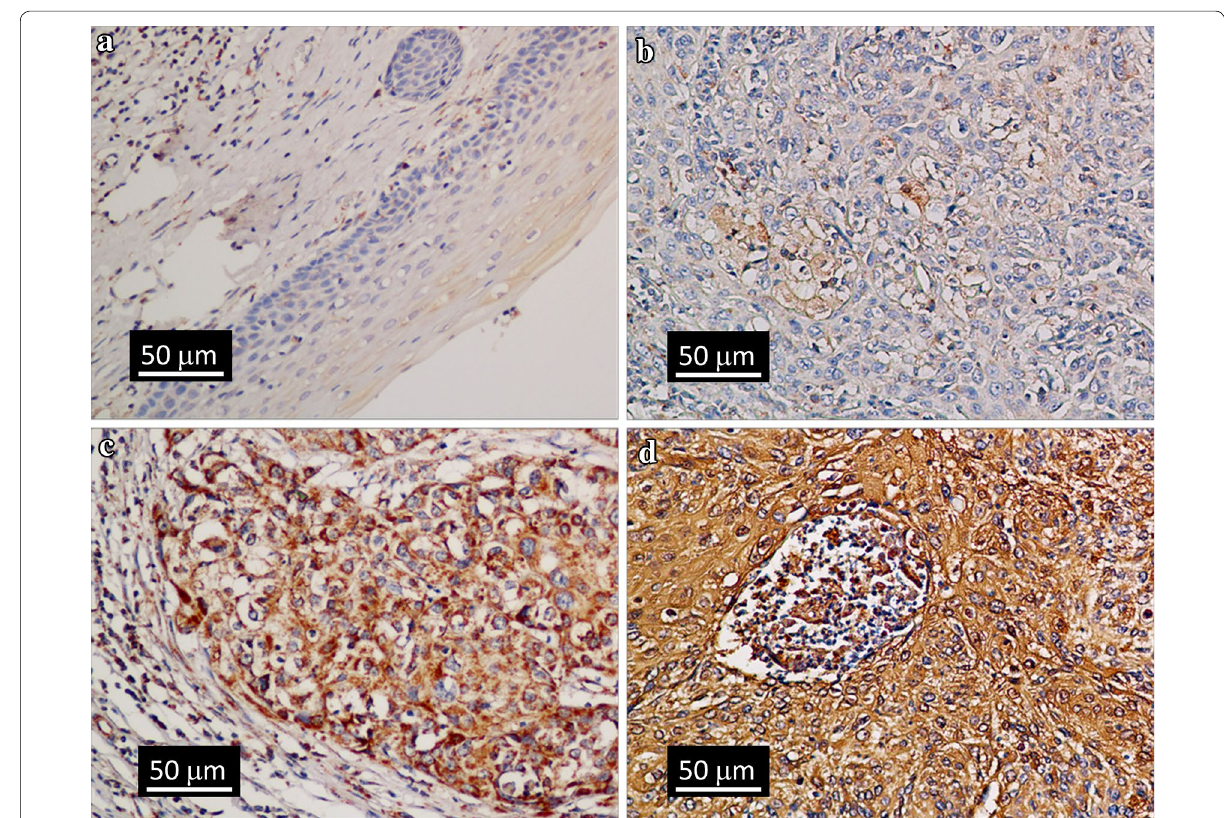
Fig. 2 Immunohistochemical analysis of PTK6 expression in normal cervical epithelial tissues and cervical squamous cell cancer tissues. a PTK6 pro‑ tein is not expressed in normal cervical epithelia. b PTK6 protein is weakly stained in the cytoplasm of cervical squamous cell cancer; c PTK6 protein is moderately stained in the cytoplasm of cervical squamous cell cancer; d PTK6 protein is strongly stained in the cytoplasm of cervical squamous cell